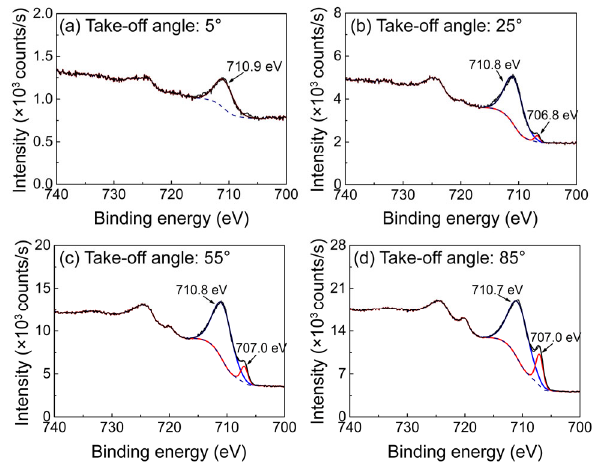
Fig. 7 XPS Fe(2p) spectra of the polished pure iron surface obtained at four different photoelectron take-off